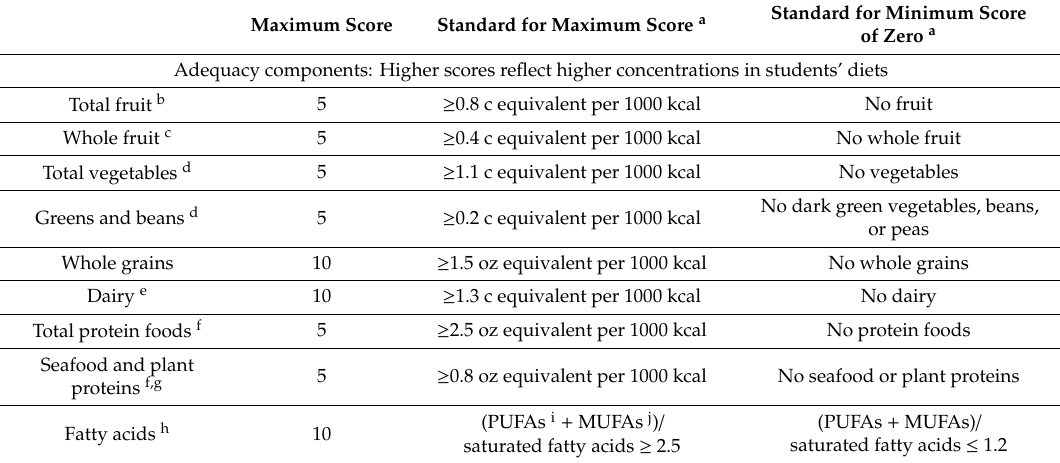
Table 1. Healthy Eating Index (HEI)-2010 components and standards for